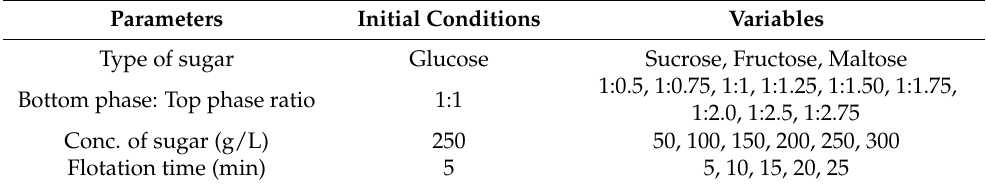
Table 1. The operating parameters of the system. All experiments were performed in triplicates. Parameters Initial Conditions Variables Type of sugar Glucose Sucrose, Fructose, Maltose Bottom phase: Top phase ratio